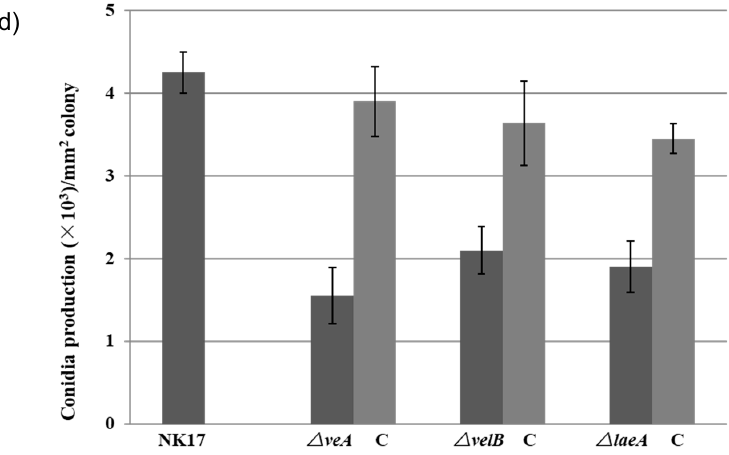
Figure 2. ( a ) Vegetative growth of the mutant strains △ veA , △ velB , and △ laeA on potato lactose agar (PLA) plates grown for four days (top) and 7 days (bottom) at 28 °C under laboratory illumination. ( b ) Colony sizes of NK17, △ veA , △ velB , and △ laeA , and the respective complement strains grown on PLA plates for seven days at 28 °C. Error bars represent standard deviation. ( c ) Microscopic analysis for hyphal tip branches of △ veA , △ velB , and △ laeA grown on minimal medium (MM) plates for five days at 28 °C when compared with NK17 and the complemented strains. ( d ) Conidia production per mm 2 of colony in NK17, △ veA , △ velB , and △ laeA, and the respective complement strains were grown on PLA. Triplicate PLA plates for each strain were incubated at 28 °C for eight days. Error bars represent the standard deviation.